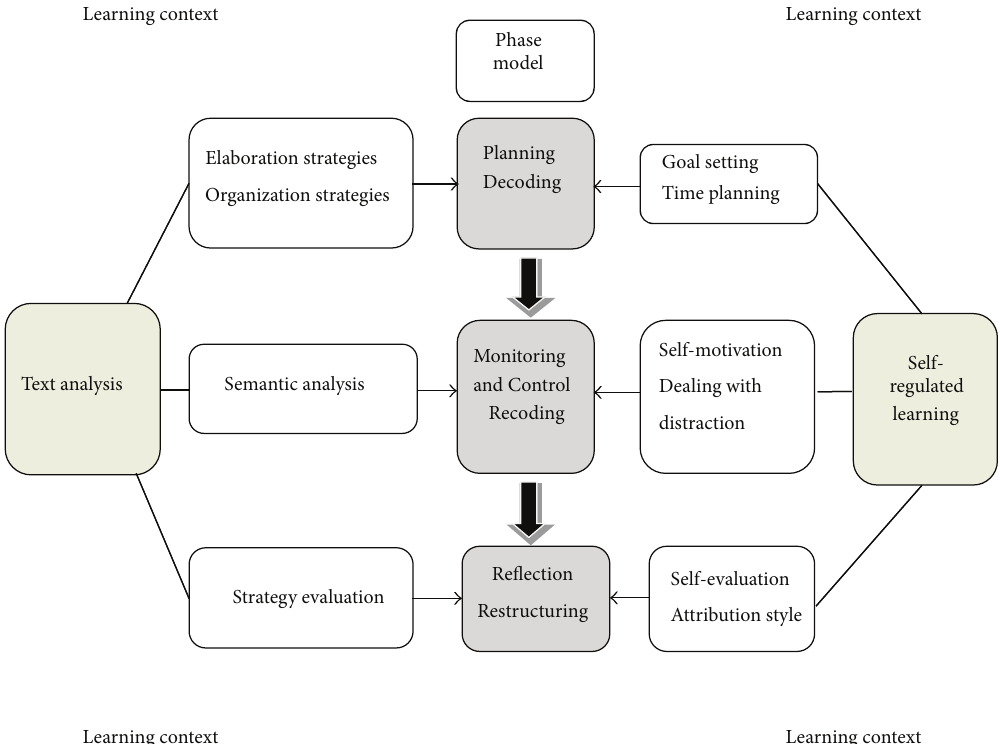
Figure 1: Framework of SRL and text analysis (in adaptation of